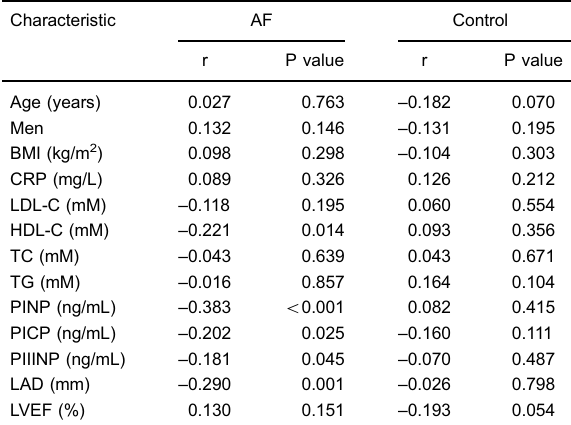
Table 2. Correlation between hsa-miR-4443 levels and clinical parameters in atrial fi brillation (AF) patients and control group.